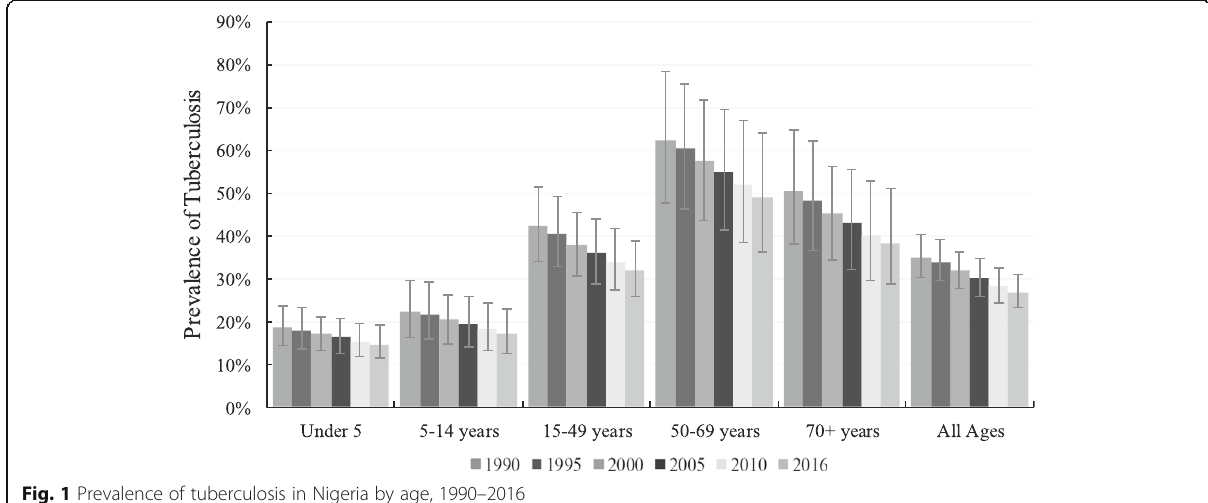
Fig. 1 Prevalence of tuberculosis in Nigeria by age, 1990 –